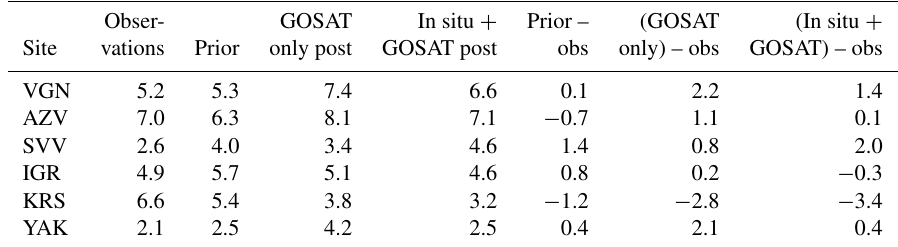
Obser- GOSAT In situ + Prior – (GOSAT (In situ + Site vations Prior only post GOSAT post obs only) – obs GOSAT) –